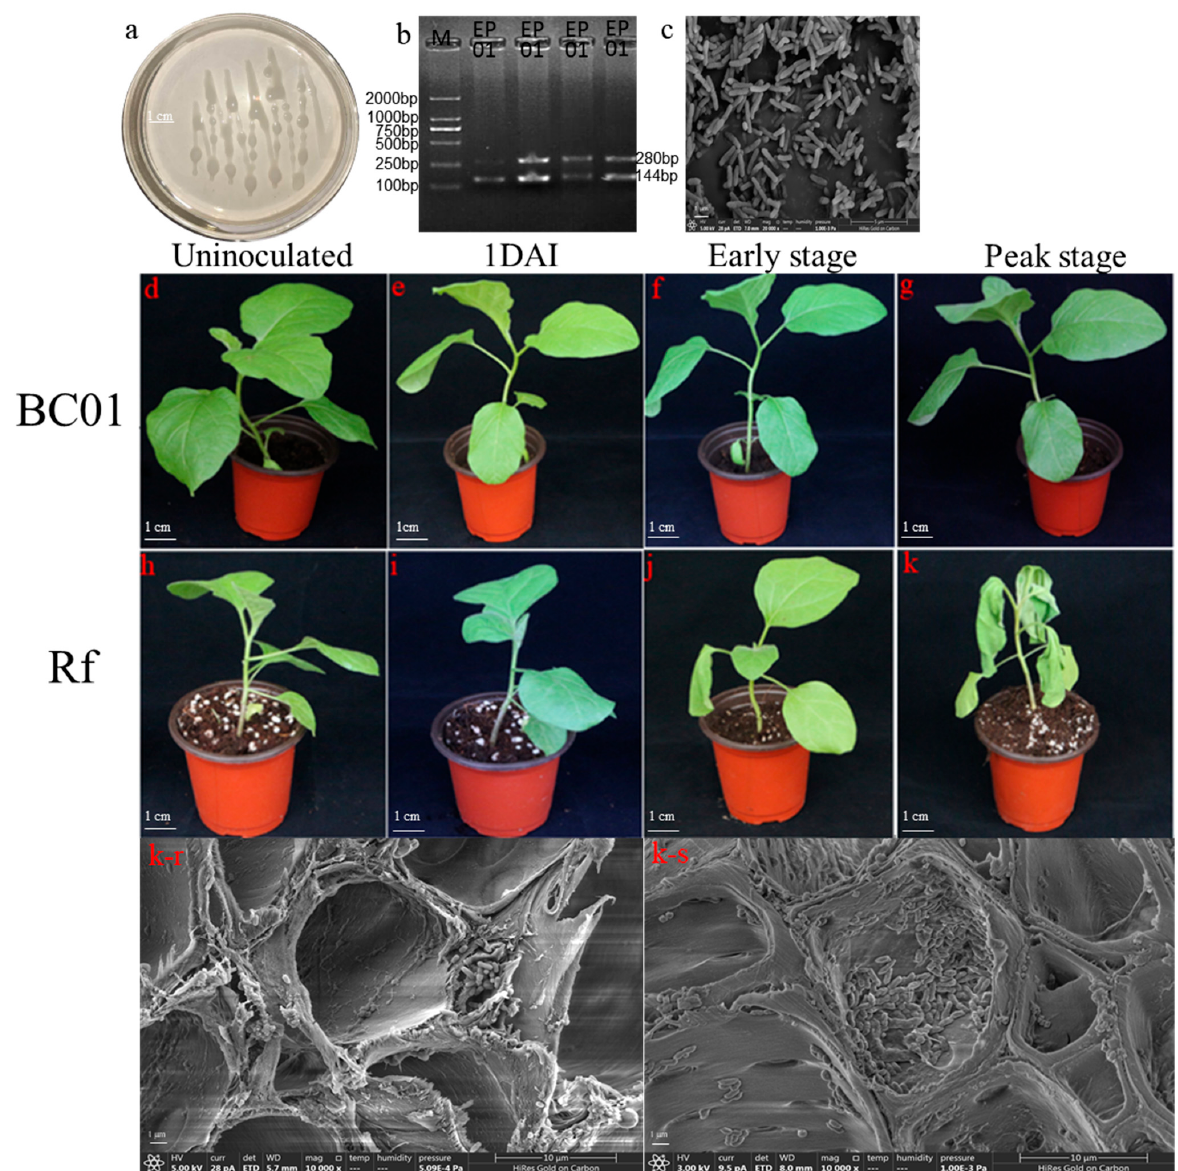
Figure 1. Identification of Ralstonia solanacearum , plant phenotype, and histological observation. ( a ) R. solanacearum in NA medium, ( b ) Specific and phylotype DNA fragments of R. solanacearum in agarose electrophoresis. ( c ) R. solanacearum